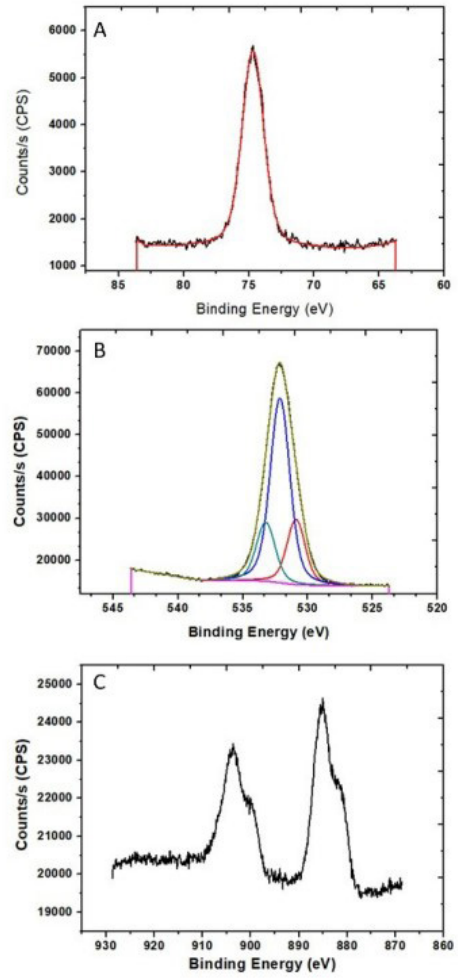
Figure 8. High-resolution spectra of CeHT treated surface of AA1230 clad on AA2024 alloy; where (A) Al 2p, (B) O 1s and (C) Ce